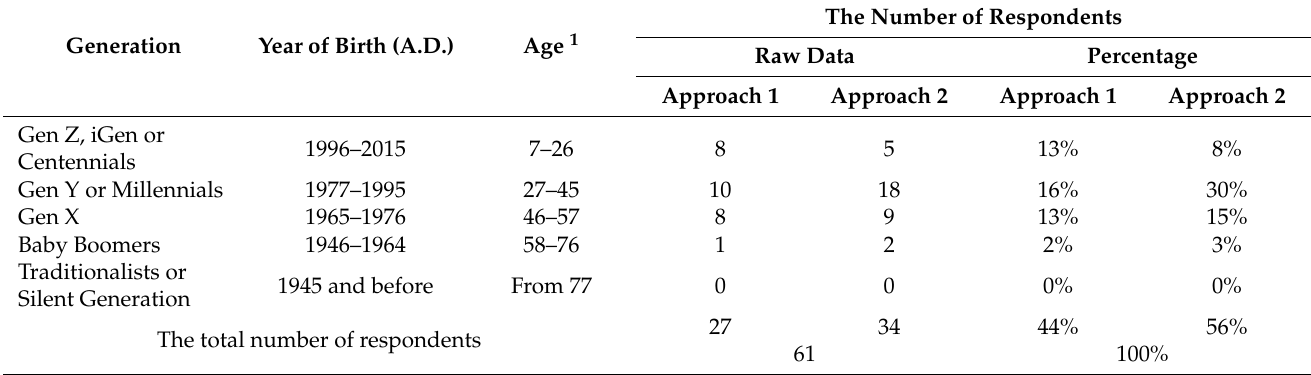
Table 2. Preferences for two design approaches shown with a generational breakdown.